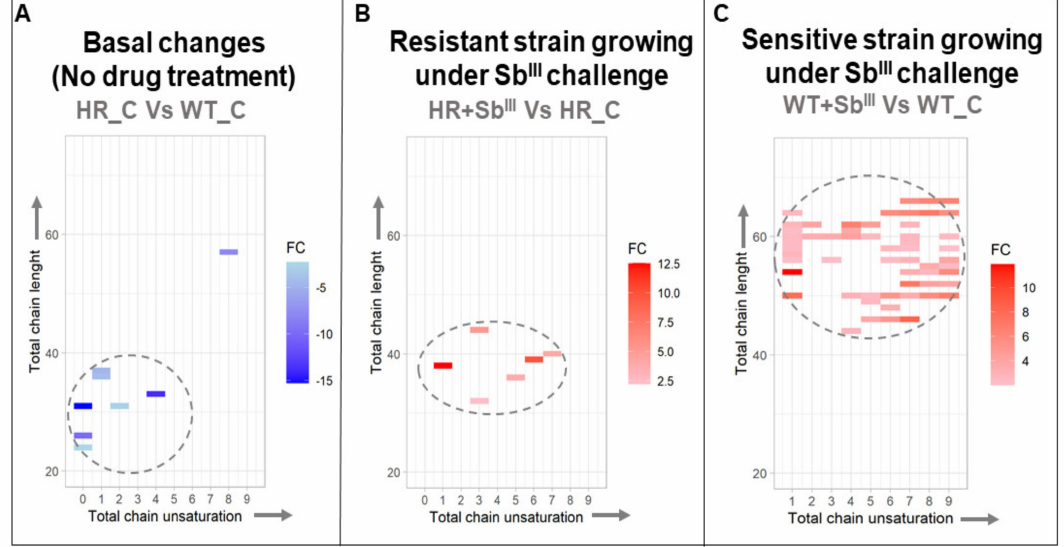
Figure 7. The upregulation of triglycerides with long-chain fatty acids is correlated with the antimony sensitive phenotype. The data from three biological repeats were analyzed. The charts represent the log 2-fold change of differentially expressed triglycerides (gradient color bar), distributed by the total chain lengths ( Y -axis) and total unsaturation levels of fatty acids contained in triglycerides ( X -axis). ( A ) Basal antimony resistant phenotype changes. ( B ) Resistant strain responding to Sb III . ( C ) Sensitive strain responding to Sb III . The downregulated and upregulated triglycerides (TGs) are represented by blue and red cells, respectively. Dotted lines highlight the main distribution of TGs per